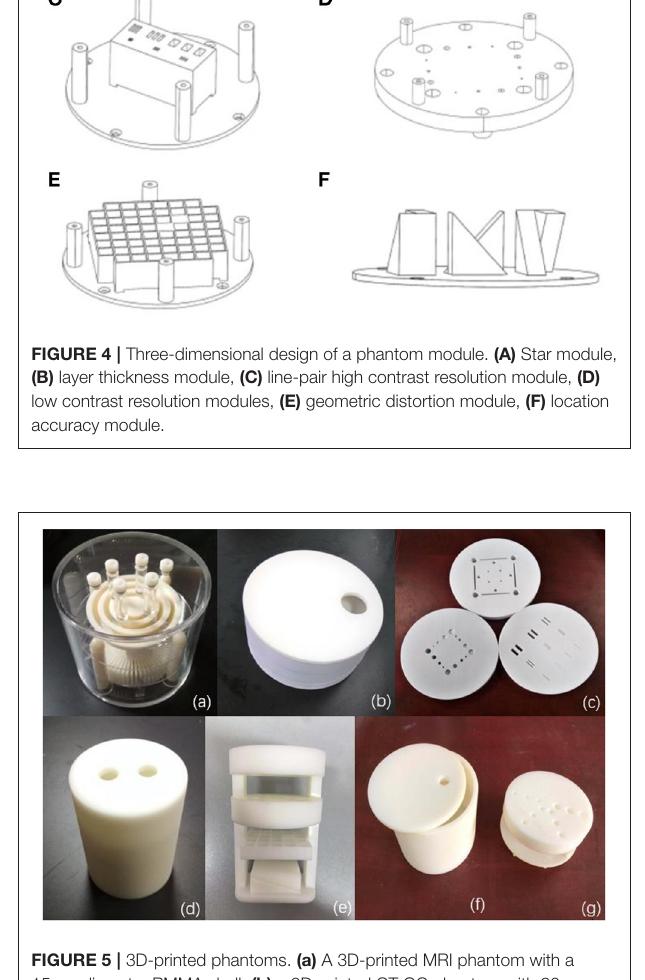
FIGURE 5 | 3D-printed phantoms. (a) A 3D-printed MRI phantom with a 15cm diameter PMMA shell, (b) a 3D-printed CT QC phantom with 20cm diameter shell, (c) shows the customizable internal inserts of the CT QC phantom (d) a 3D-printed PET/MRI phantom with 6cm diameter shell, (e) shows the customizable internal inserts of the PET/MRI phantom, (f) a 3D-printed PET/CT phantom with 9.3cm diameter shell, (g) shows the customizable internal inserts of the PET/CT